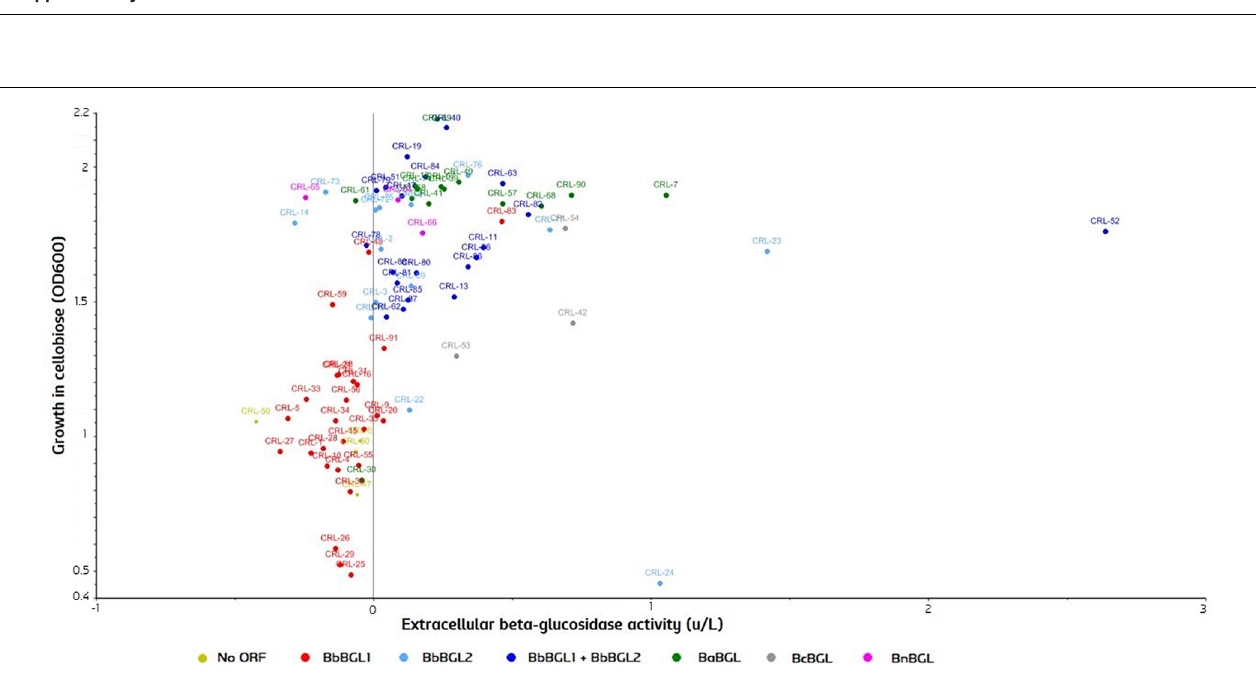
FIGURE 7 | β -glucosidase activity in cultures grown on cellobiose as sole carbon source (OD600) and extracellular activity measured (units/L). Strains are grouped according to the identified ORF in the genome. Statistical tests of the current experimental data can be found in Supplementary Material .